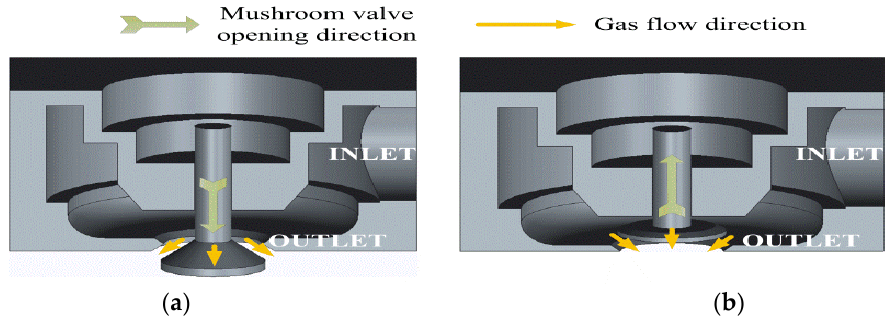
Figure 2. Internal structure of the gas fuel injector: ( a ) Push-open injector; ( b ) Pull-open injector.